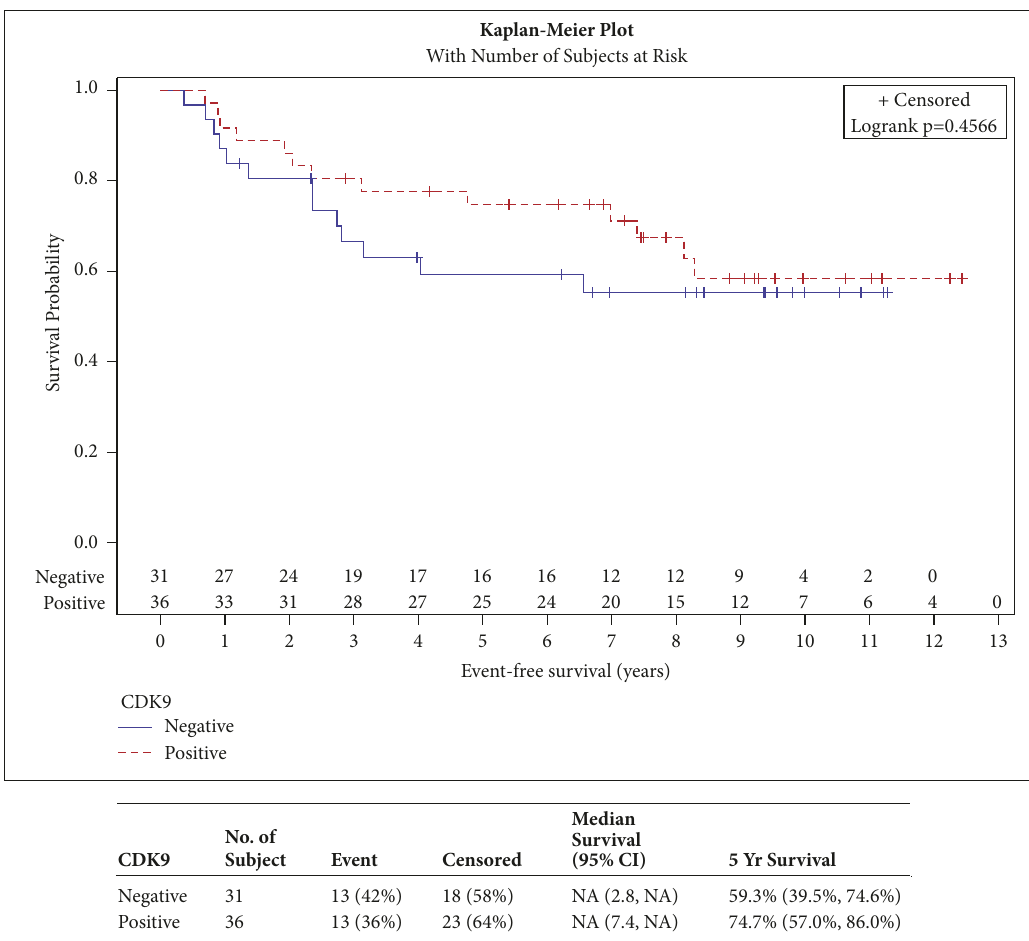
Figure 5: Event-free survival . Figure 5 shows curves comparing event-free survival in patients with CDK9 positive versus CDK9 negative tumors. There is no statistically significant or observable difference in the two survival